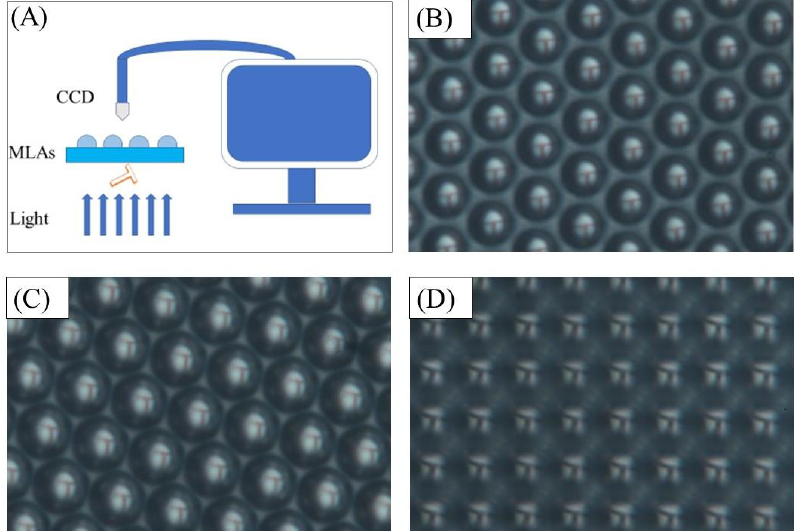
Figure 6. ( A ) The schematic of the imaging system and the virtual images of ( B ) circular, ( C ) hexagonal, and ( D ) square photoresist film MLAs.